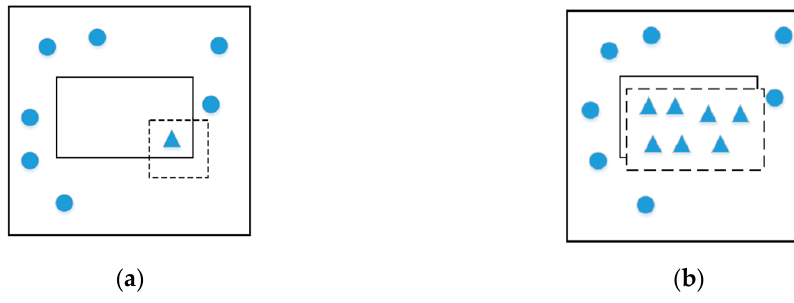
Figure 1. The schematic diagram of the impact of unbalanced data on the classification algorithm. ( a ) Unbalanced data, ( b ) normal data.